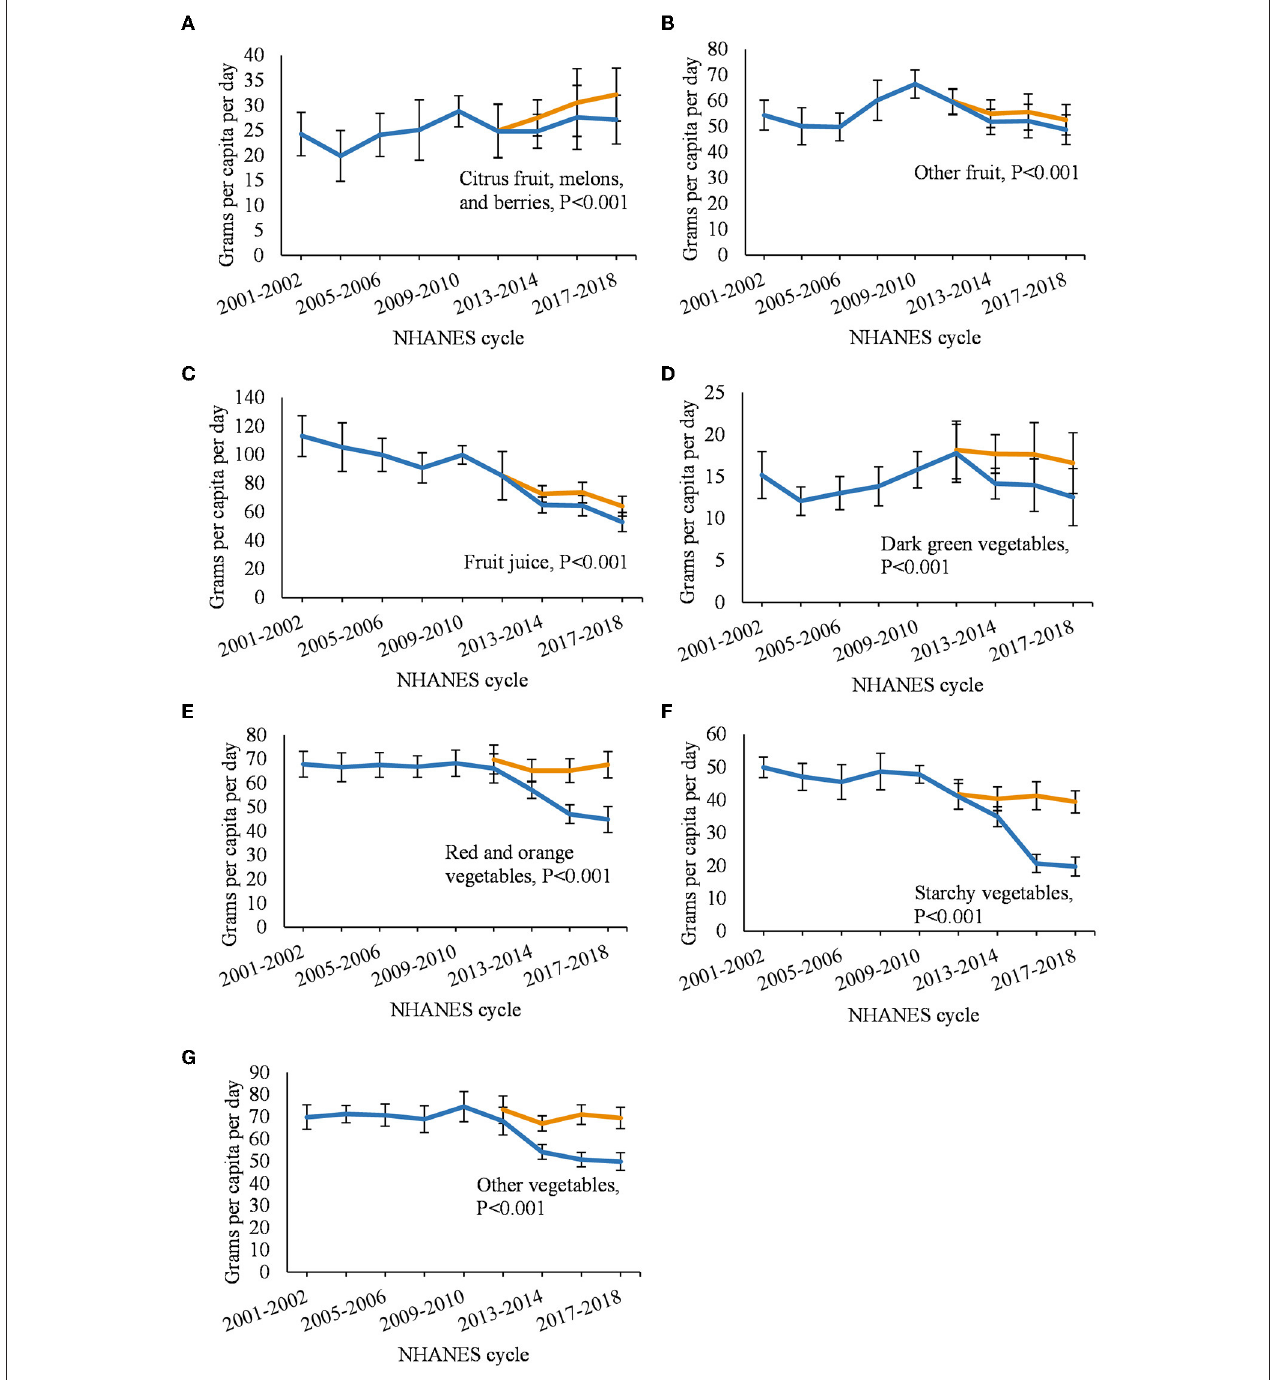
FIGURE 3 | Annual per capita food intake among US adults from 2001–2018 comparing updated and non-updated Food Commodity Intake Database (FCID). (A) citrus fruit, melons, and berries; (B) other fruit; (C) fruit juice; (D) dark green vegetables; (E) red and orange vegetables; (F) starchy vegetables; and (G)